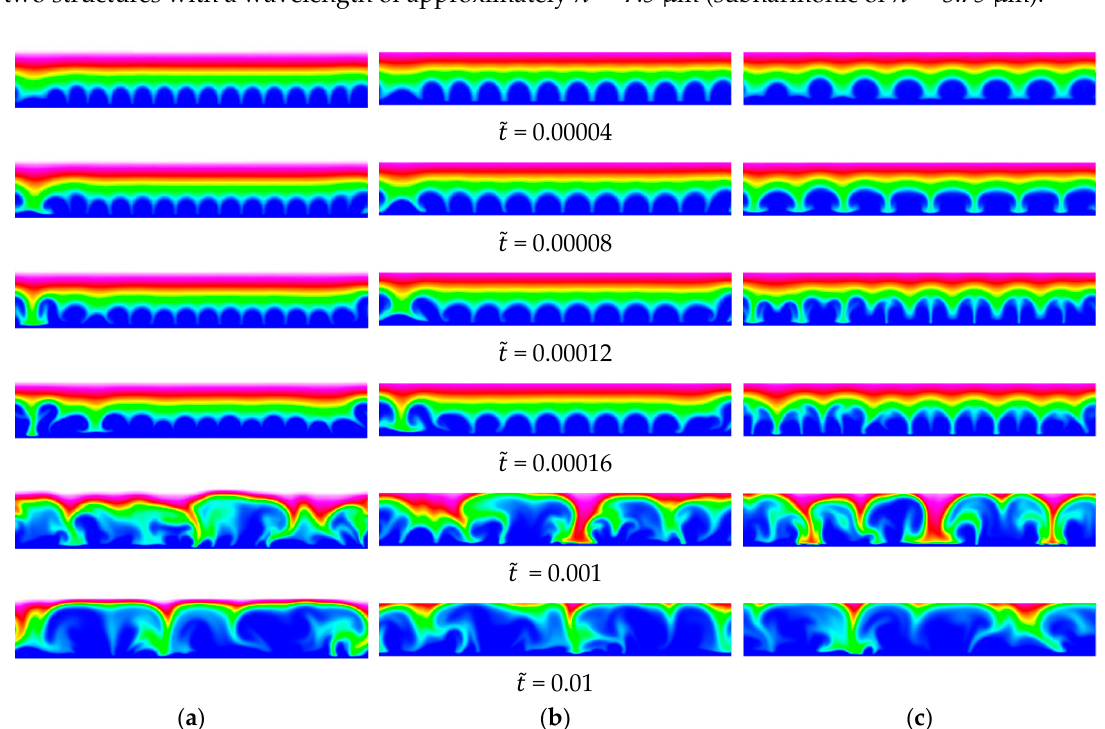
Figure 14. Baseline 2-D case, 𝑉(cid:3560) = 120. Wavy membrane with 𝐴 = 0.01 μm and ( a ) 𝜆 = 3.75 μm , ( b ) 𝜆 = 5 μm and ( c ) 𝜆 = 7.5 μm . Anion concentration.